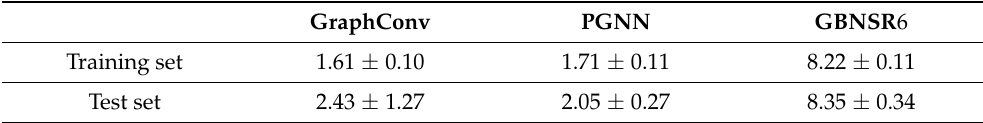
Table 3. Error in calculating ∆∆ G values of the GraphConv model (data-driven), the PGNN model (hybrid), and the GBRNSR6 model (physics-based) on the host–guest dataset. RMSE values are in kcal/mol.